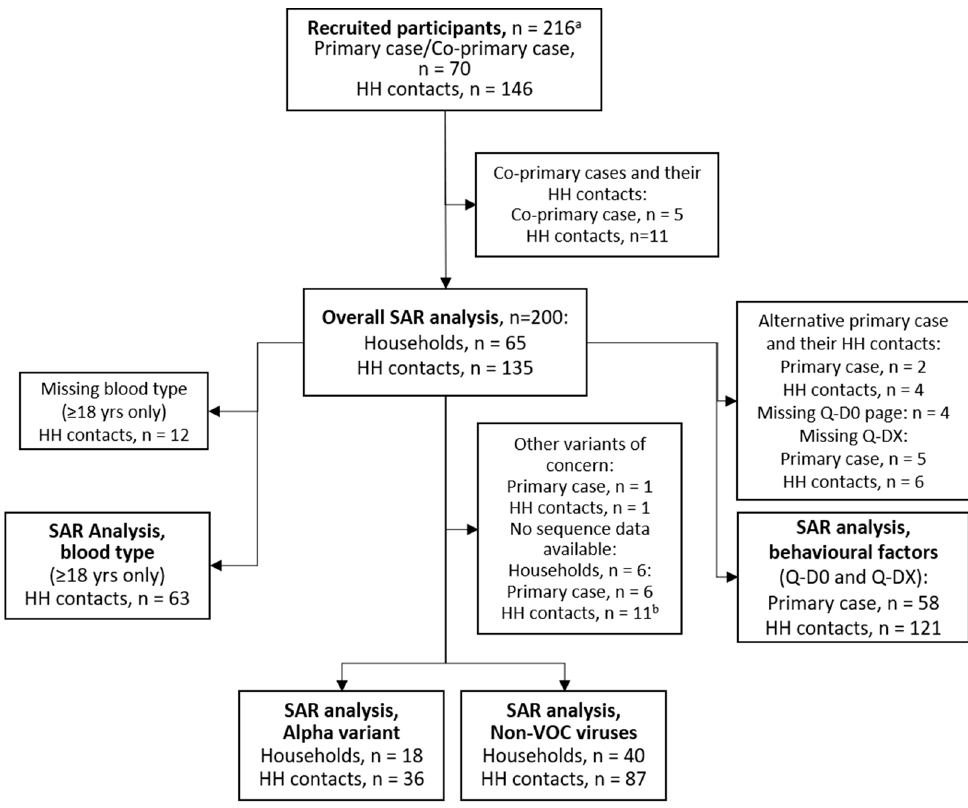
Figure 2. Flow chart of participant selection for the different analyses. a recruited participants were tested for SARS-CoV-2 by rRT-PCR and provided information on symptom onset (Q-D0 question- naire). b includes household contacts that were SARS-CoV-2 negative.